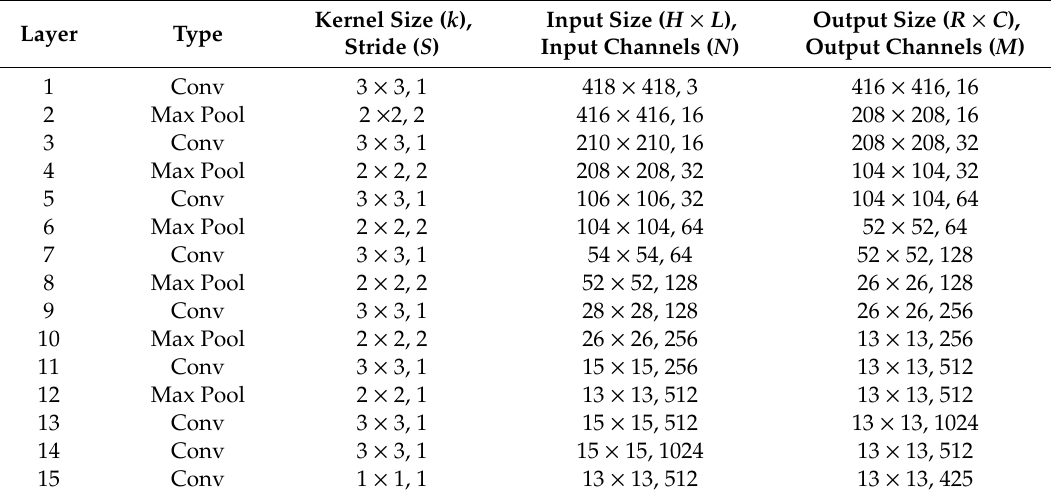
Table 1. Structure of You Only Look Once (YOLO)